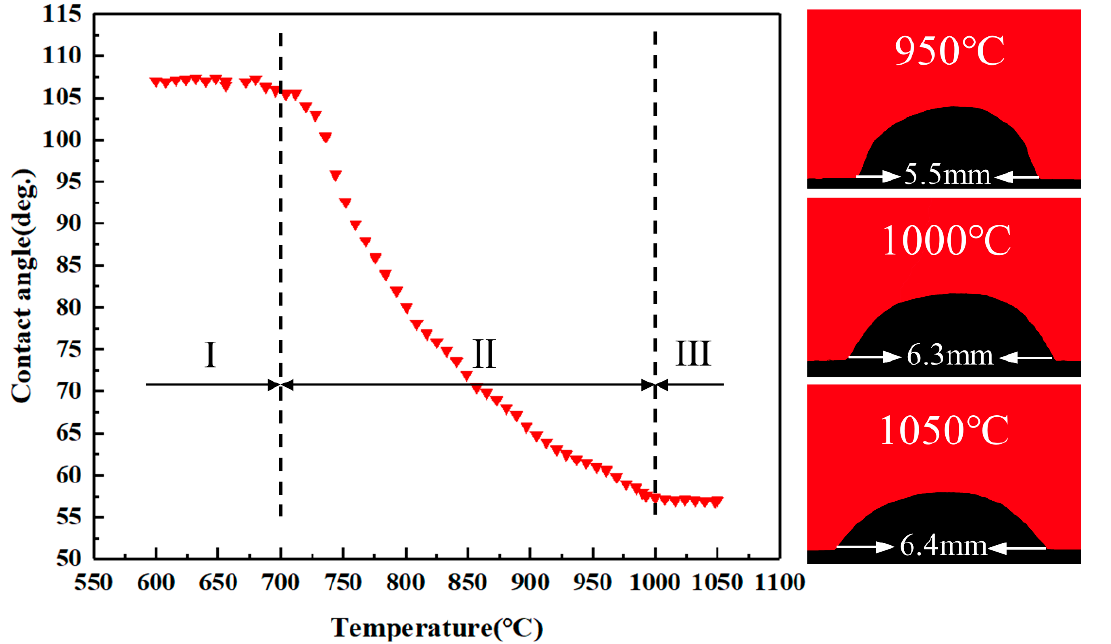
Figure 2. Variation of contact angle for Sn-3Ti/sapphire system at different wetting temperatures and profiles of drops at 950 °C, 1000 °C, and 1050 °C.